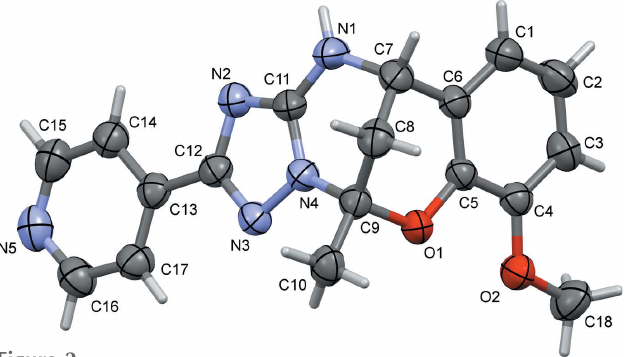
Figure 2 The molecular structure of compound II , with the atom labelling. Displacement ellipsoids are drawn at the 50% probability level.